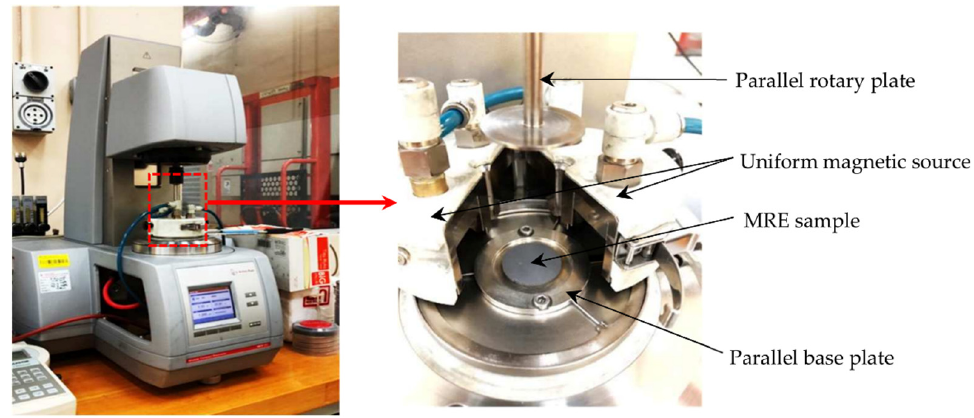
Figure 2. MCR 302 rheometer, MRD 70/1T magnetorheological device, and sample on a base